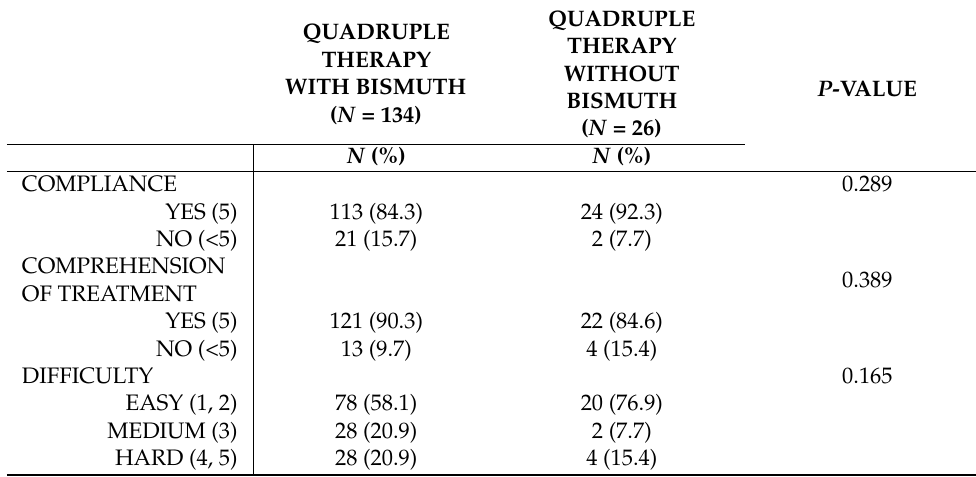
Table 4. Compliance, degree of difficulty and comprehension of the